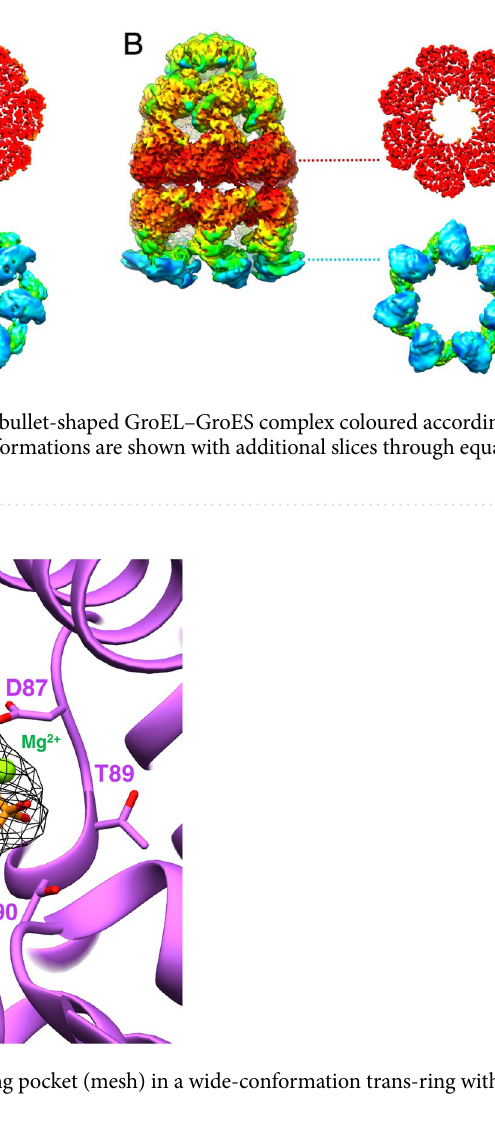
(C7) for the “wide” and “tight” states, respectively (Supplementary Fig. S2). While a certain degree of symmetry- mismatch in the apical domains of the trans ring was observed in the symmetry-free (C1) structures, extensive